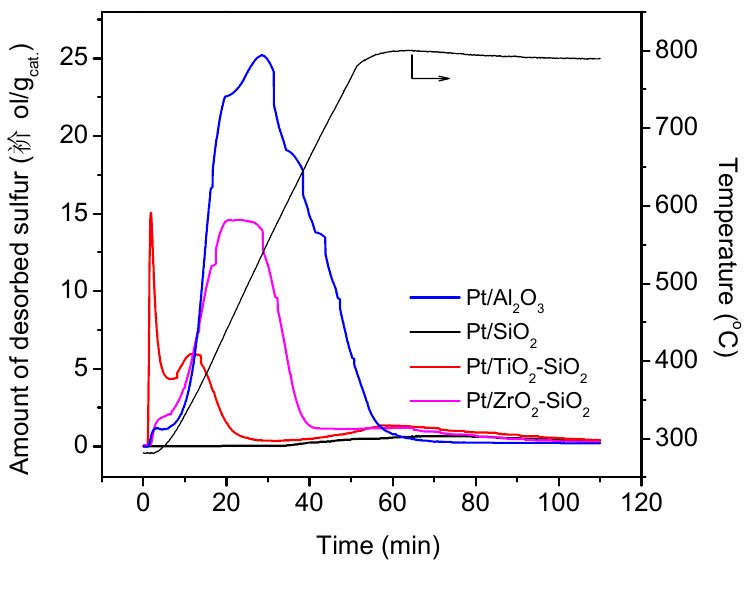
Figure 5. Sulfur release profiles during H Pt/TiO -SiO , and Pt/ZrO 2 2